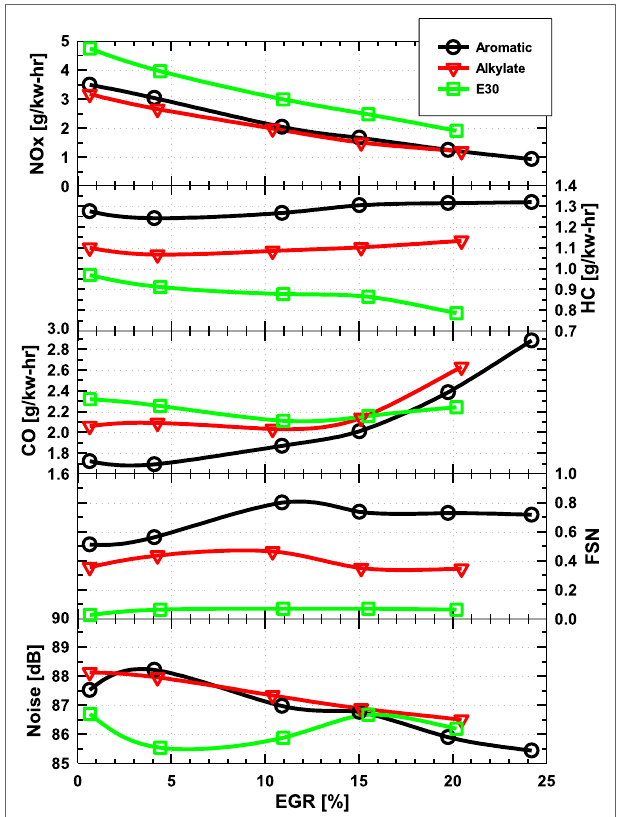
FigUre 6 | Exhaust gas recirculating (EGR) sweep (0–25%) results with intake pressure adjustment for constant combustion phasing: emission of (NOx, HC, and CO), filter smoke number (FSN), and combustion